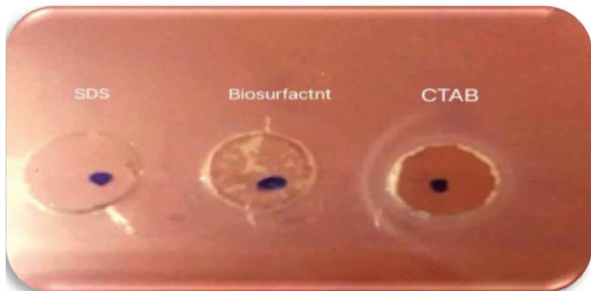
Figure 14: Te agar double difusion test showing the anionic nature of biosurfactant produced by P. guguanensis strain Iraqi ZG.K.M versus diferent tension-active agents of known